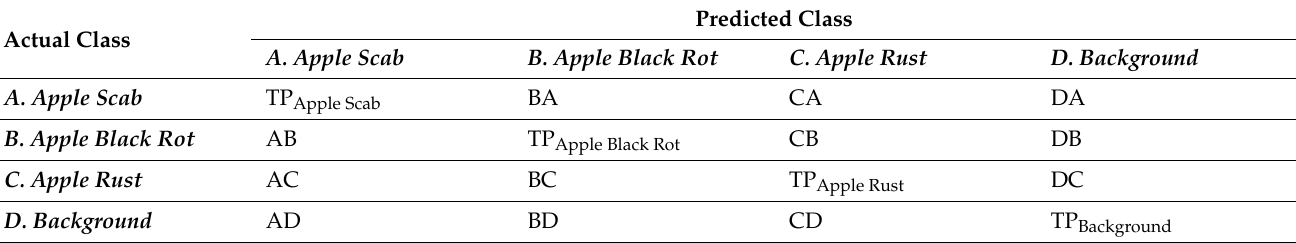
Table 6. Example of a multi-class confusion matrix (4 ×